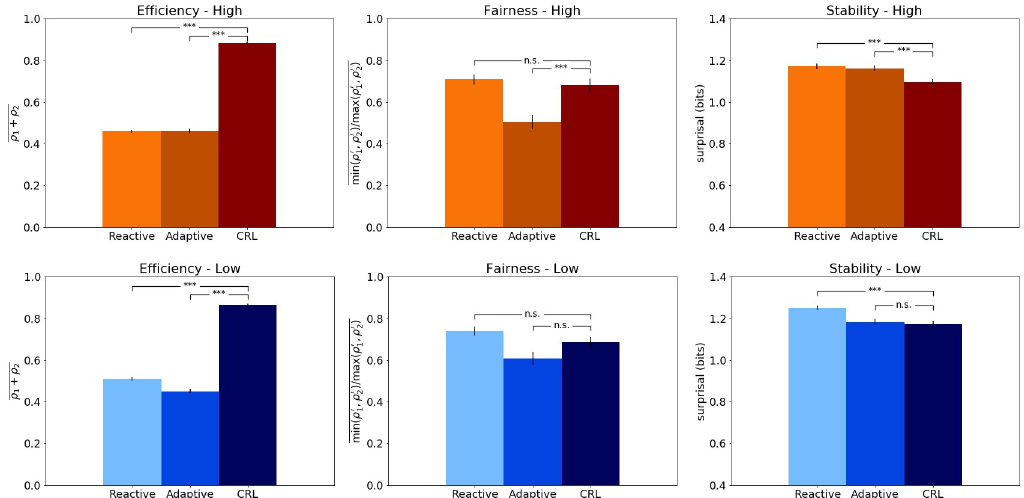
Fig 7. Model ablation results. Top panel: Results of the model-ablation experiments compared to the complete CRL results. Orange bars shows the results of the high-payoff conditions, whereas the blue bars refer to the low-payoff conditions. The Reactive model operates using only the Reactive Layer’s sensorimotor control. The adaptive-only operates using only the Adaptive Layer’s TD-learning algorithm. All results are represented in terms of Efficiency (left panel), Fairness (center) and Stability (right panel). Note that stability is measured by the level of surprisal , which means that lower surprise values imply higher stability. All error bars reflect standard errors.